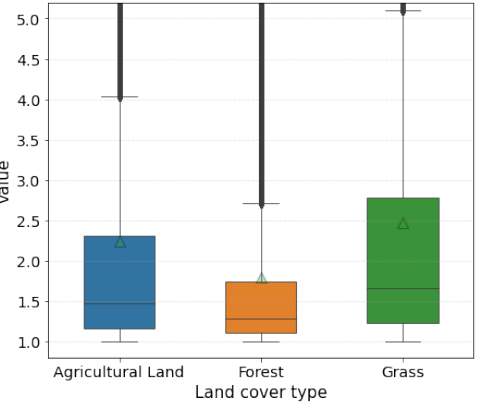
Figure 9. Comparison of ranges of EDCI-veg values by land cover.